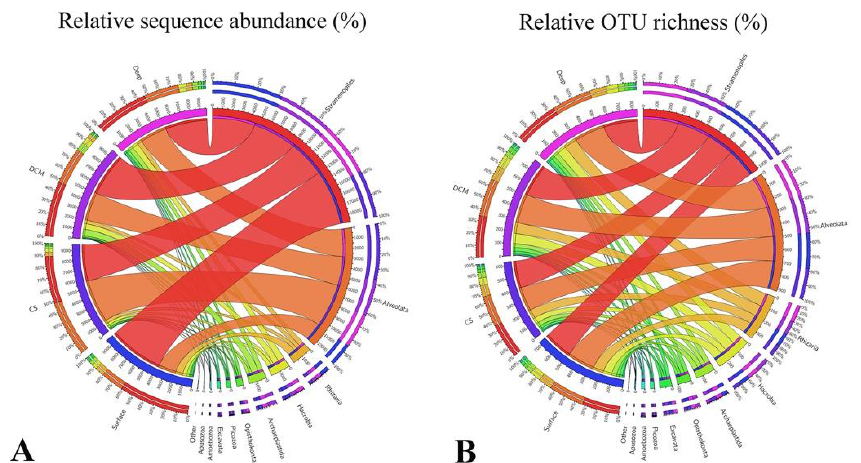
Figure 3. Overview of the relative sequence abundance ( A ) and OTU richness ( B ) of protistan assemblages in Group Surface (surface waters), Group CS (coastal subsurface waters), Group DCM (deep chlorophyll maximum), and Group Deep (deep waters), respectively.